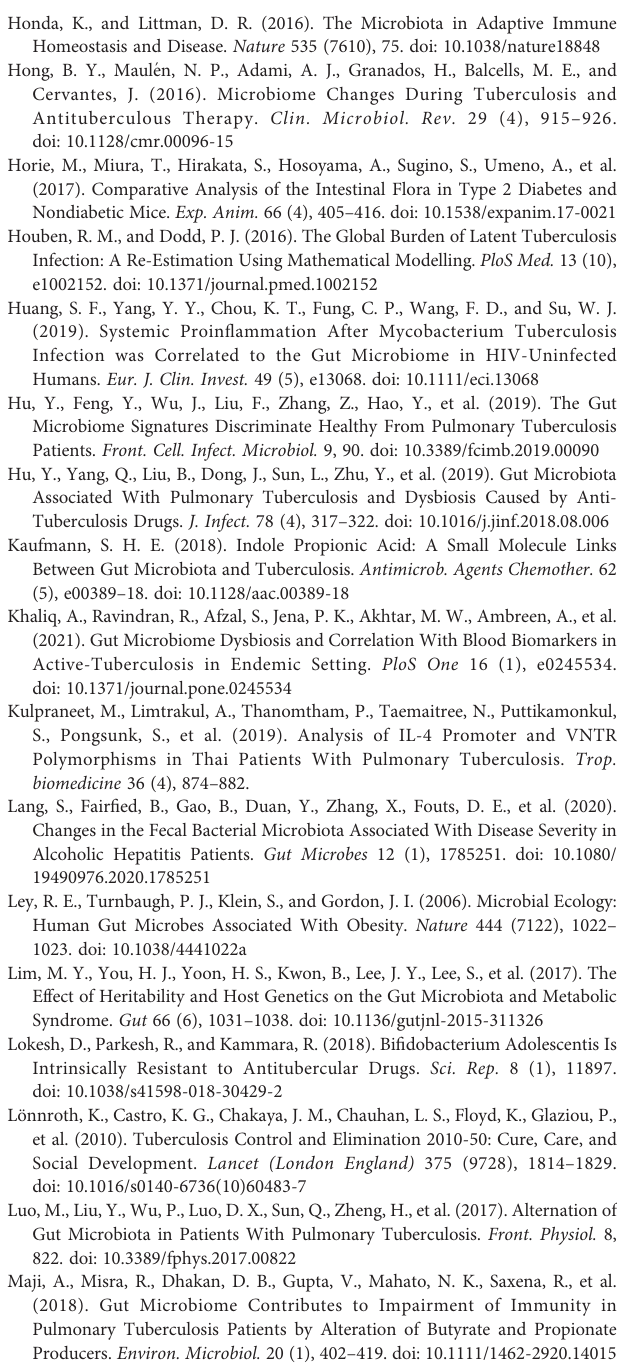
Supplementary Figure 3 | Number of optimal predictor variables in PTB and HC.